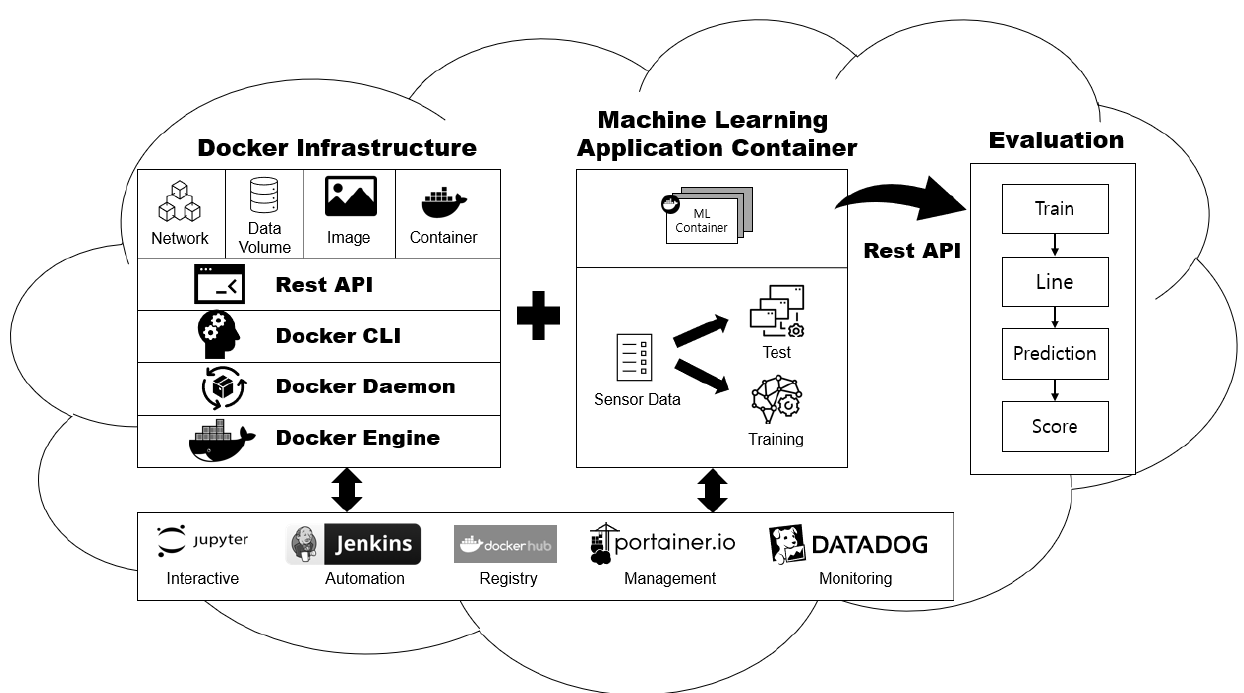
Figure 3. Docker Container-based machine-learning pass/fail inspection system on a cloud server and a docker-based monitoring system